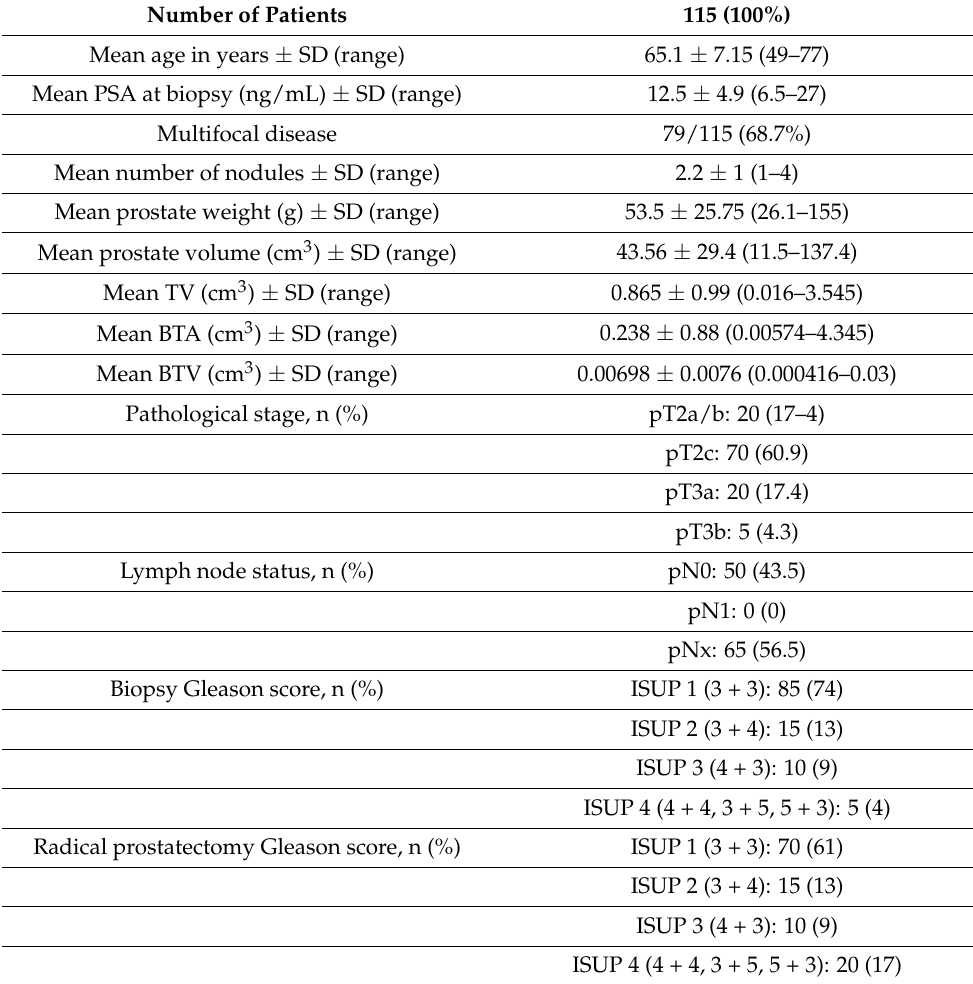
Table 1. Clinical and pathological patients’